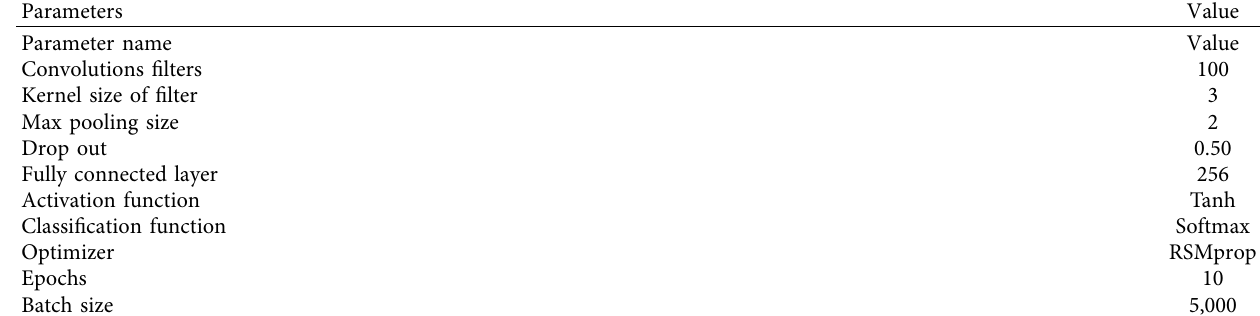
Table 6: Parameters of the proposed model.